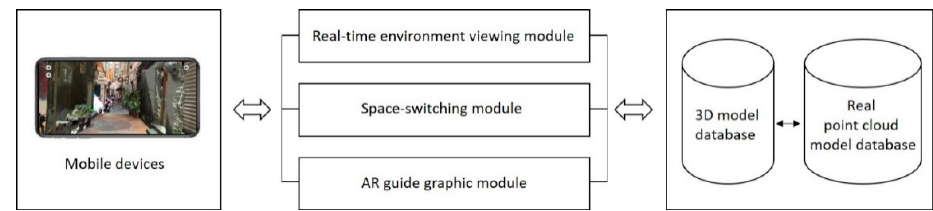
Figure 8. System Figure 8. System structure.